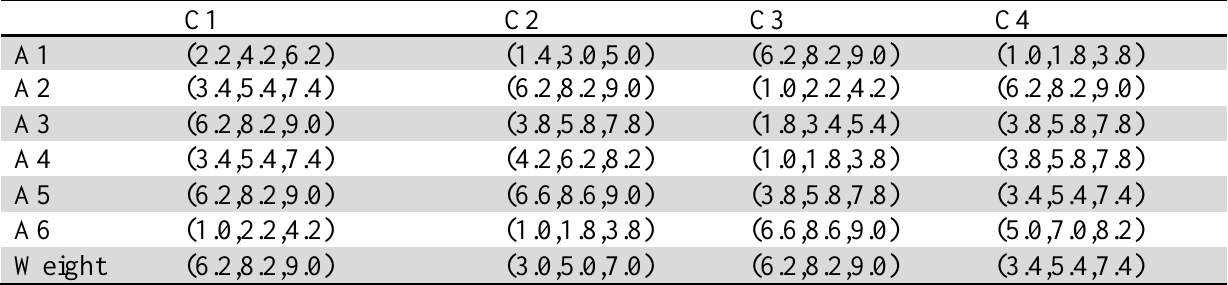
Step 1: Design fuzzy decision matrix using triangular fuzzy membership function as shown in Table 10. Fuzzy decision matrix for WQS